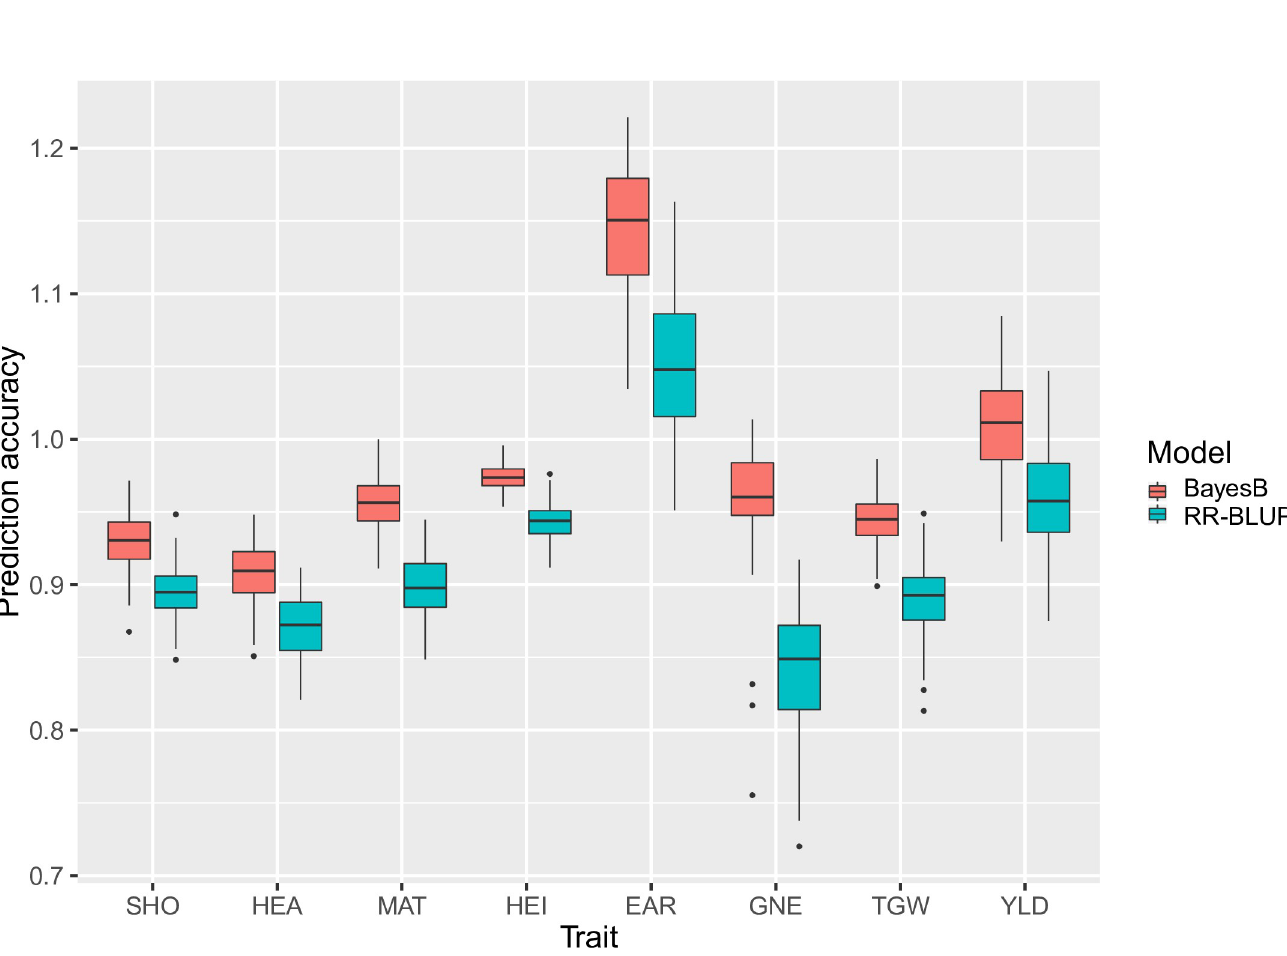
Fig 1. Cross-validated prediction accuracies of traits with SNP data using RR-BLUP and BayesB, respectively. Boxplots contain all 100 prediction values of the cross-validation runs. Red boxes show results of BayesB, while blue boxes show results of RR-BLUP. BayesB performed better for all traits. Prediction accuracies with BayesB were significantly better than with RR-BLUP for all